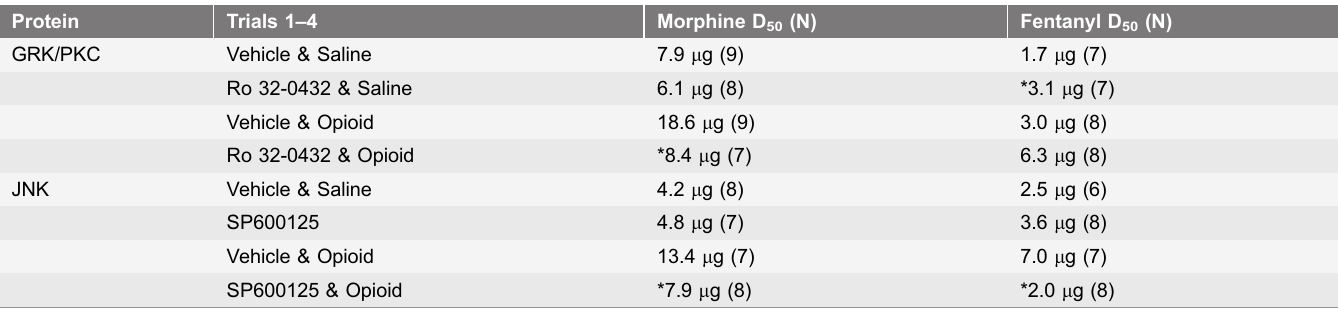
Table 2. Effect of GRK/PKC and JNK inhibition on the Development of Tolerance.